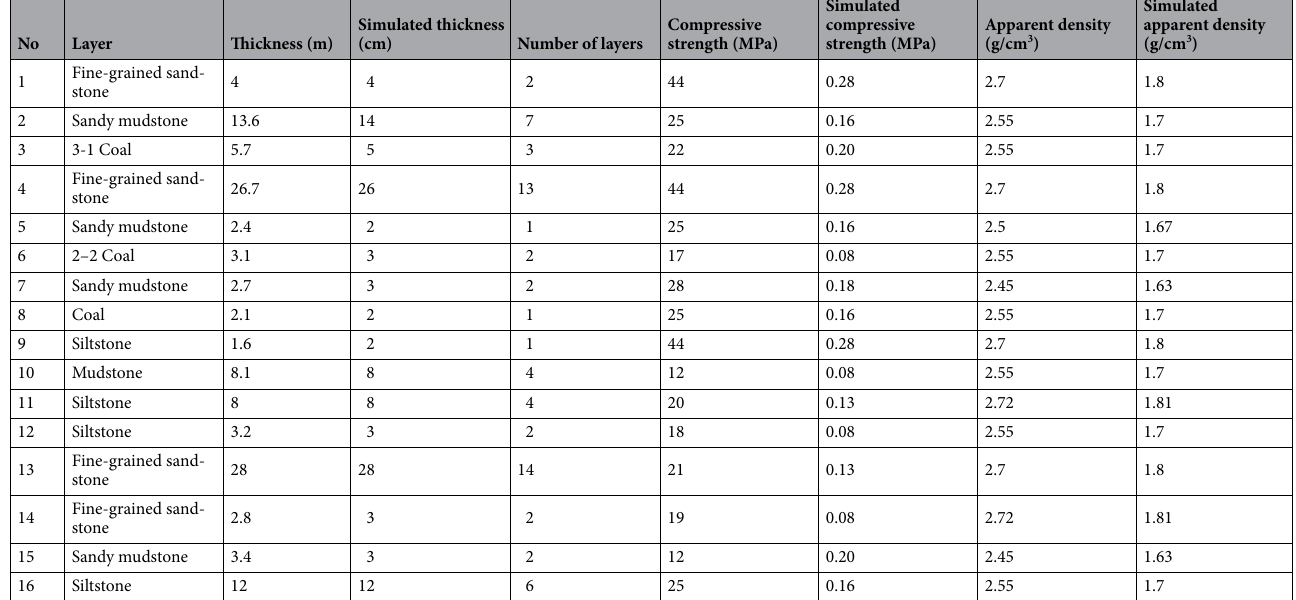
Table 1. Physical and mechanical parameters of rock